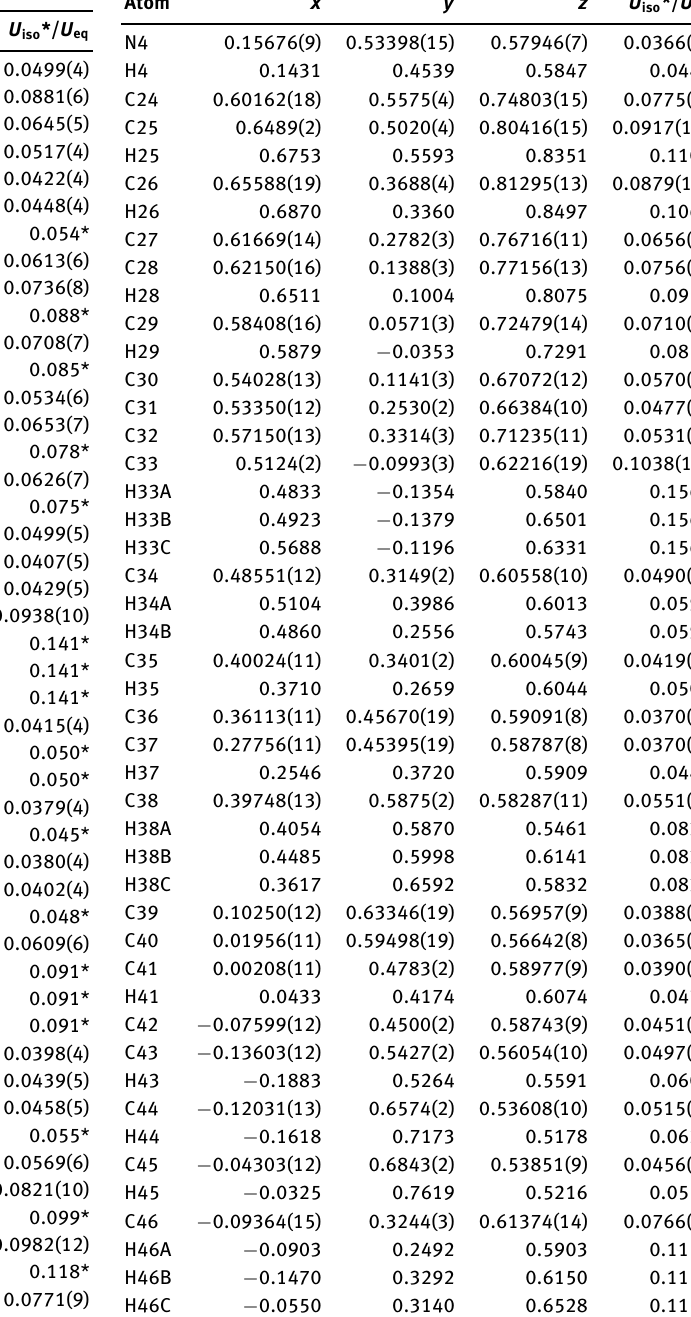
Table 2: Fractional atomic coordinates and isotropic or equivalent isotropic displacement parameters (Å 2